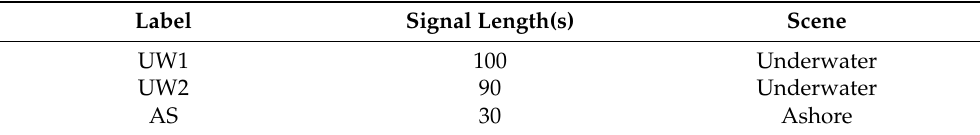
Figure 9. Waveforms of three segments of dolphin EEG signals with label ( a ) UW1, ( b ) UW2, and ( c ) AS. Table 1. The sampled EEG of the